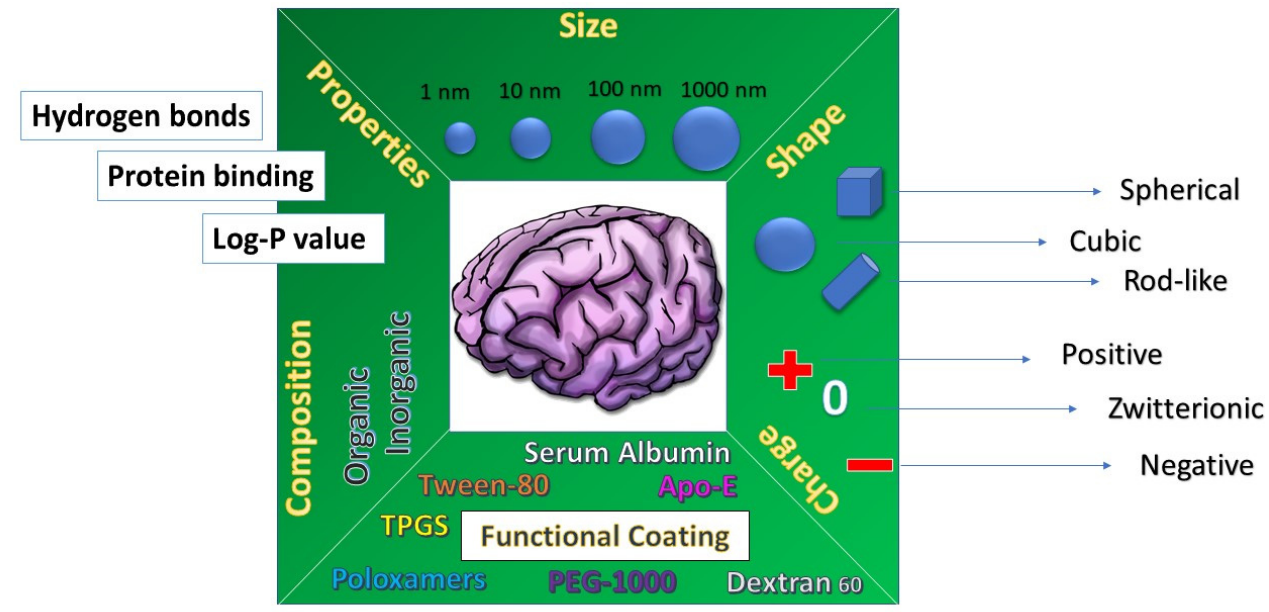
Figure 4. Properties that affect nanomedicine brain entrance and diffusion (Adapted from [125], Elsevier, 2016).